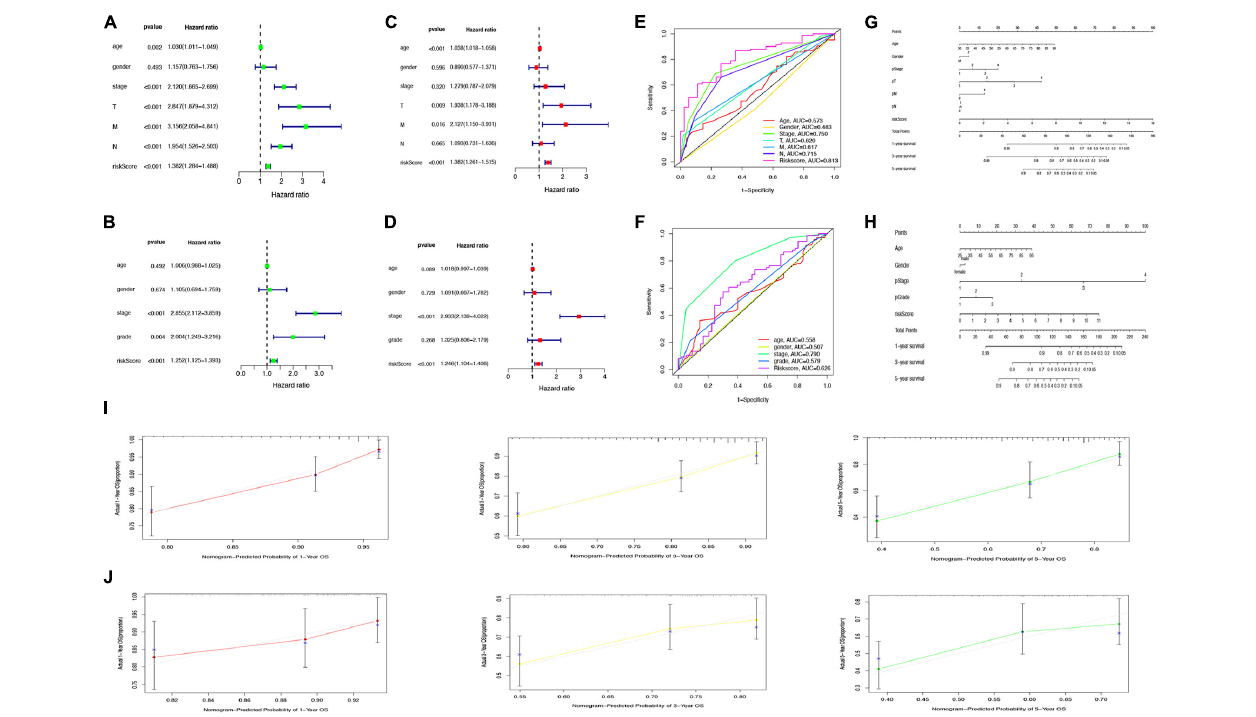
FIGURE 8 | Prediction of overall survival (OS) by risk score and clinical characteristics. (A,B) Forest plot of risk scores and other clinical factors based on a univariate Cox regression analysis in The Cancer Genome Atlas (TCGA) (A) and GSE17536 cohort (B) . (C,D) Forest plot of risk scores and other clinical factors based on a multivariate Cox regression analysis in TCGA (C) and GSE17536 (D) cohort. (E,F) Comparison of specificity and sensitivity of 5-year overall survival rate between different clinical traits and GRG risk models in TCGA (E) and GSE17536 (F) cohort. (G,H) Nomogram with a combination of risk score and different clinical traits in